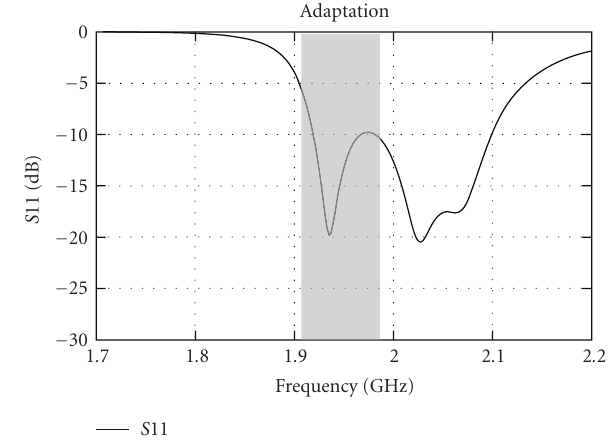
Figure 15: Return loss.